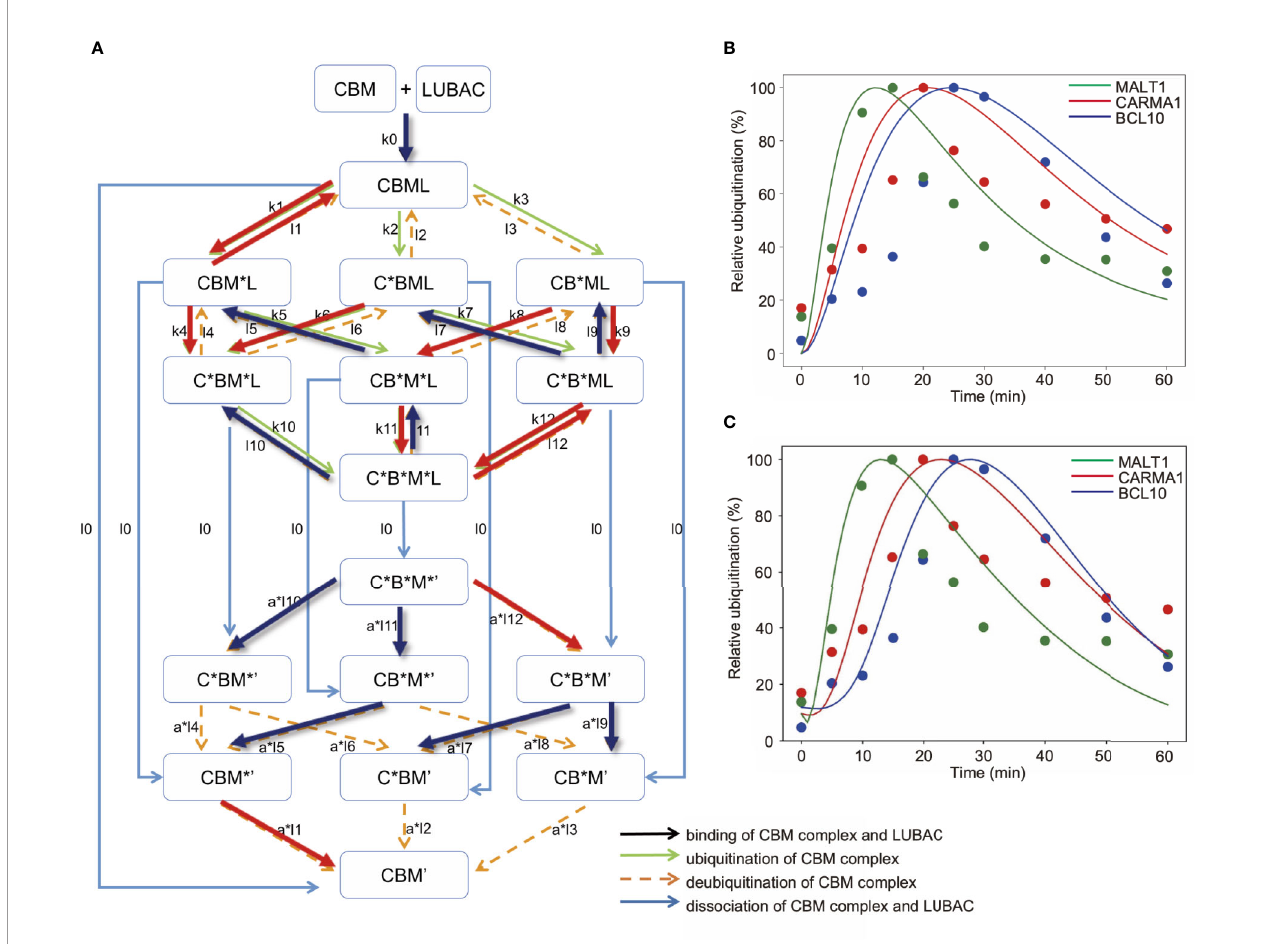
FIGURE 7 | Mathematical model for different linear ubiquitinations of the CBM complex. (A) Detailed reaction pathway of the ubiquitination of the CBM complex. The red lines show parameters that are larger than the average value. The blue lines show parameters that are smaller than the average value. (B) Fitting results by GA in the CBM_DM. (C) Fitting results by GA. The ubiquitination reaction is assumed to be a Hill